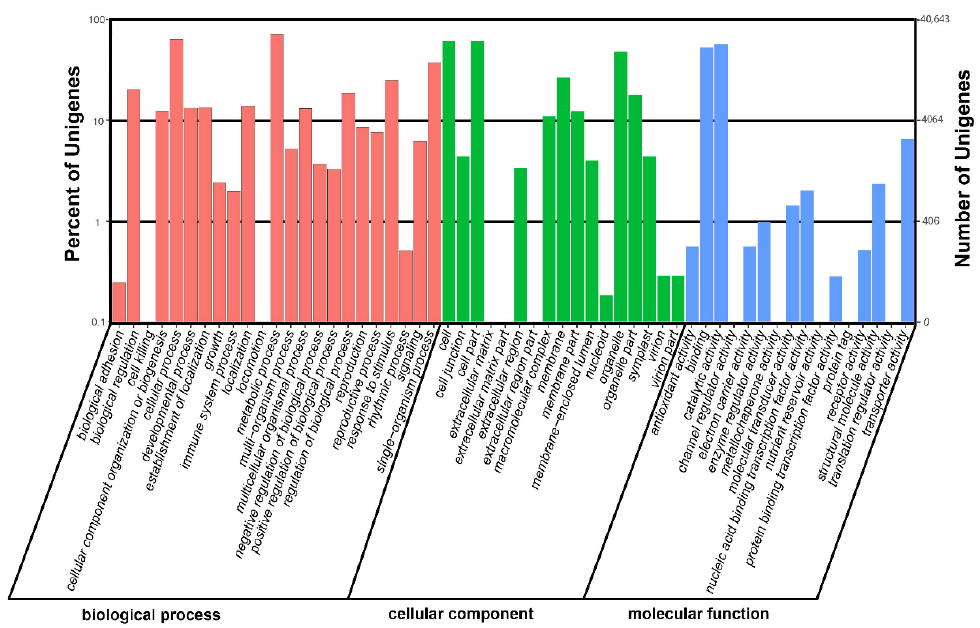
Figure 4. Gene ontology annotations of the assembled unigenes.